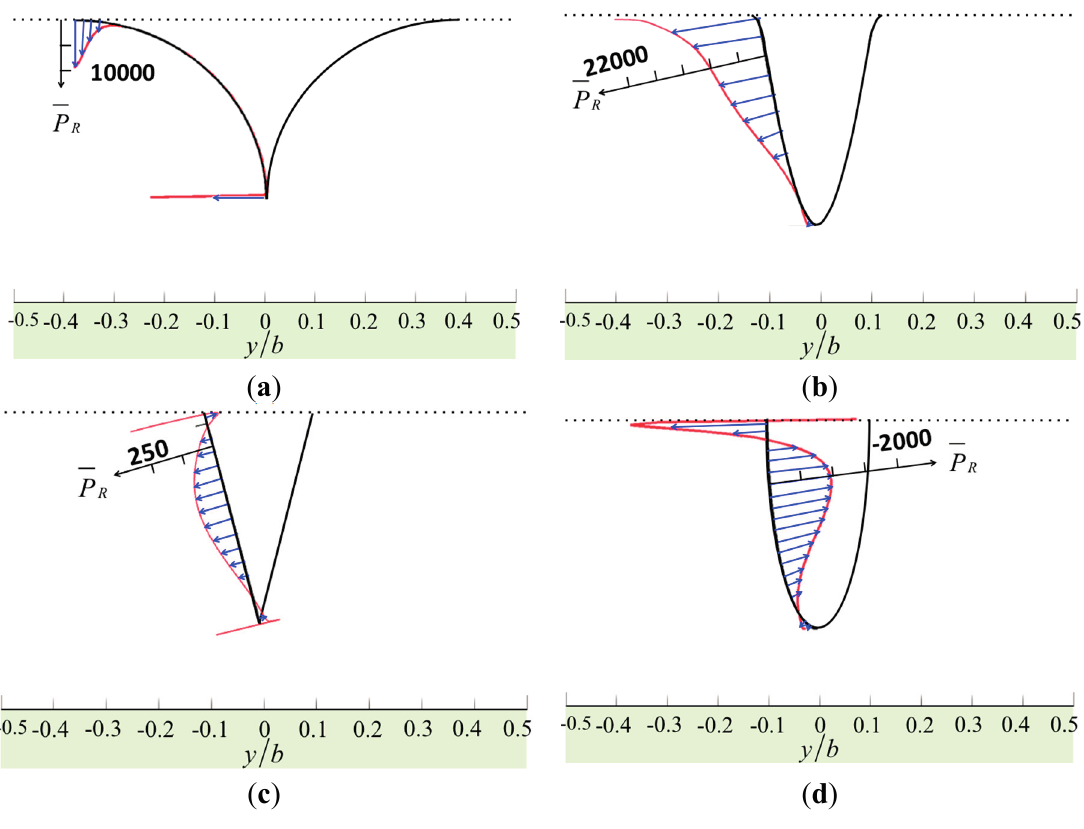
Figure 5. The normalized pressure in real part over the surfaces of the tips: ( a ) the sharp model, ( b ) the sine-shaped model; ( c ) the cone-shaped model; and ( d ) the bell-shaped